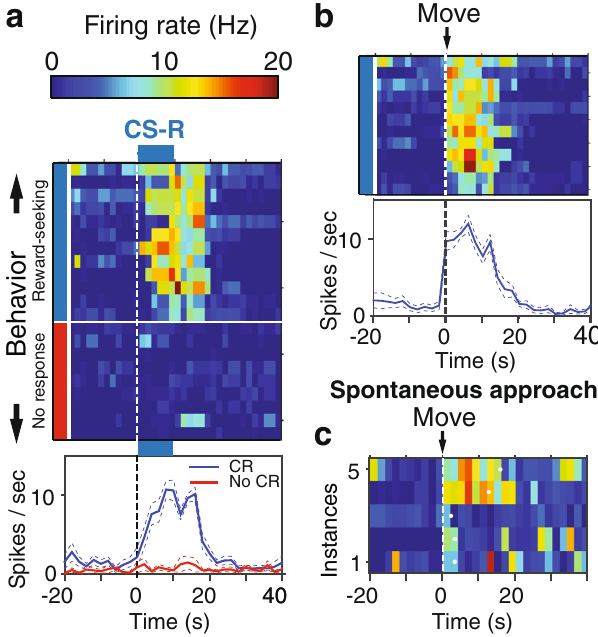
Fig. 2 Activity of BL neurons during CSs varies depending on behavior. Rats were presented with two CS, one of which predicted reward delivery (CS-R) and the second (CS-N), a neutral outcome. After rats learned to retrieve the liquid reward at the conclusion of the CS-R, the two CSs were presented in random order while recording BL neurons. a Activity of a principal BL cell during multiple presentations of the CS-R. Activity is depicted as a color-coded raster ( top ) and peri-CS histogram of neuronal discharges ( bottom ; solid and dashed lines are averages and SEM, respectively). Trials are grouped by behavior as indicated by the colored bar on the left of the rasters ( blue , approach of water-port; red , no approach). Rasters and peristimulus histograms in b depict the activity of the same cell as in a , but aligned to onset of water-port approach instead of CS onset. Note higher variations in fi ring latency when activity